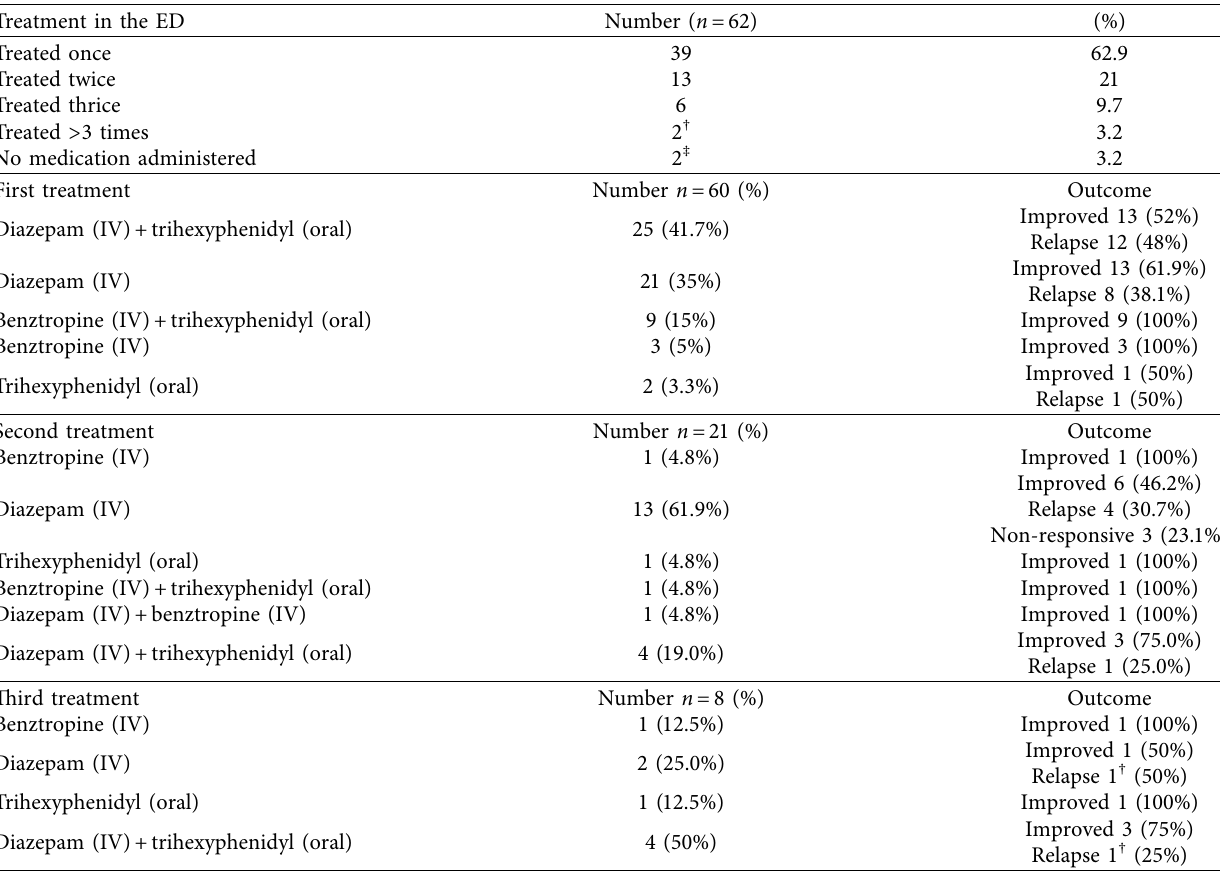
Table 5: Treatment and outcomes.